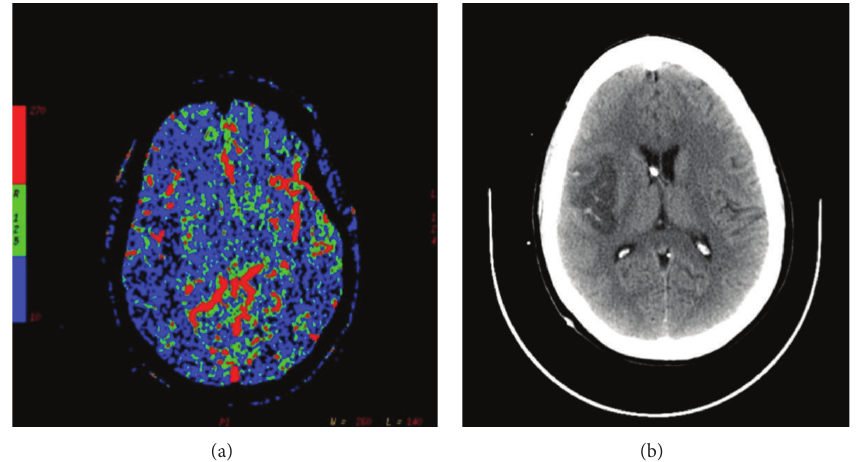
F 10: CT Perfusion. Decreased perfusion secondary to vasospasm in the le middle cerebral artery territory on CTP (a). Corresponding ischemia is noted on CT scan